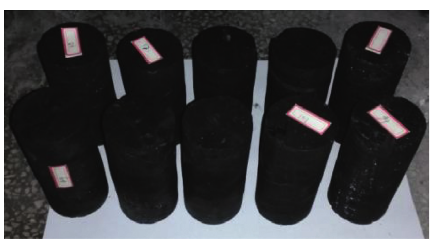
Figure 3: Raw coal specimen